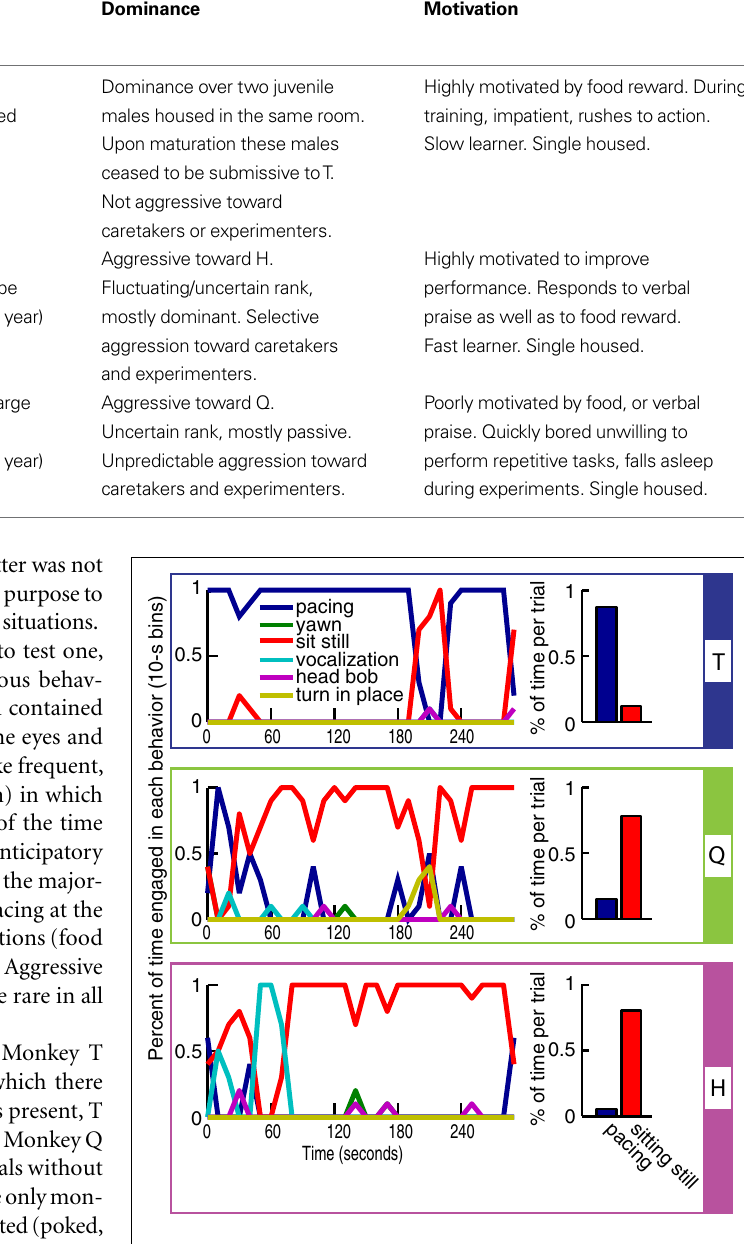
FIGURE 2 | Ethogram accounting for all the spontaneous behaviors. These behaviors occurred during 5 min when a familiar caretaker approached the cage of each monkey with a bucket of food but instead of delivering the food into the monkey’s feeding tray stood in the front of the cage without making eye contact with the monkey. The bar graphs on the right show for each monkey the relative ratio of sitting quietly and pacing.